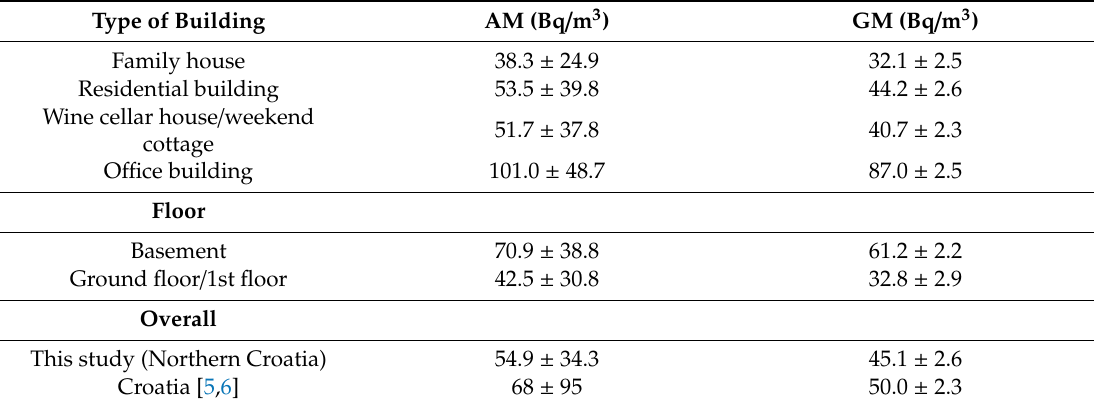
Table 3. Average indoor radon concentration values measured in di ff erent building types and floors compared to overall results and national indoor radon levels in Croatia [5]. Radon concentrations for Northern Croatian region shown in Figure 1b [6] are set to be between 51–100 Bq / m 3